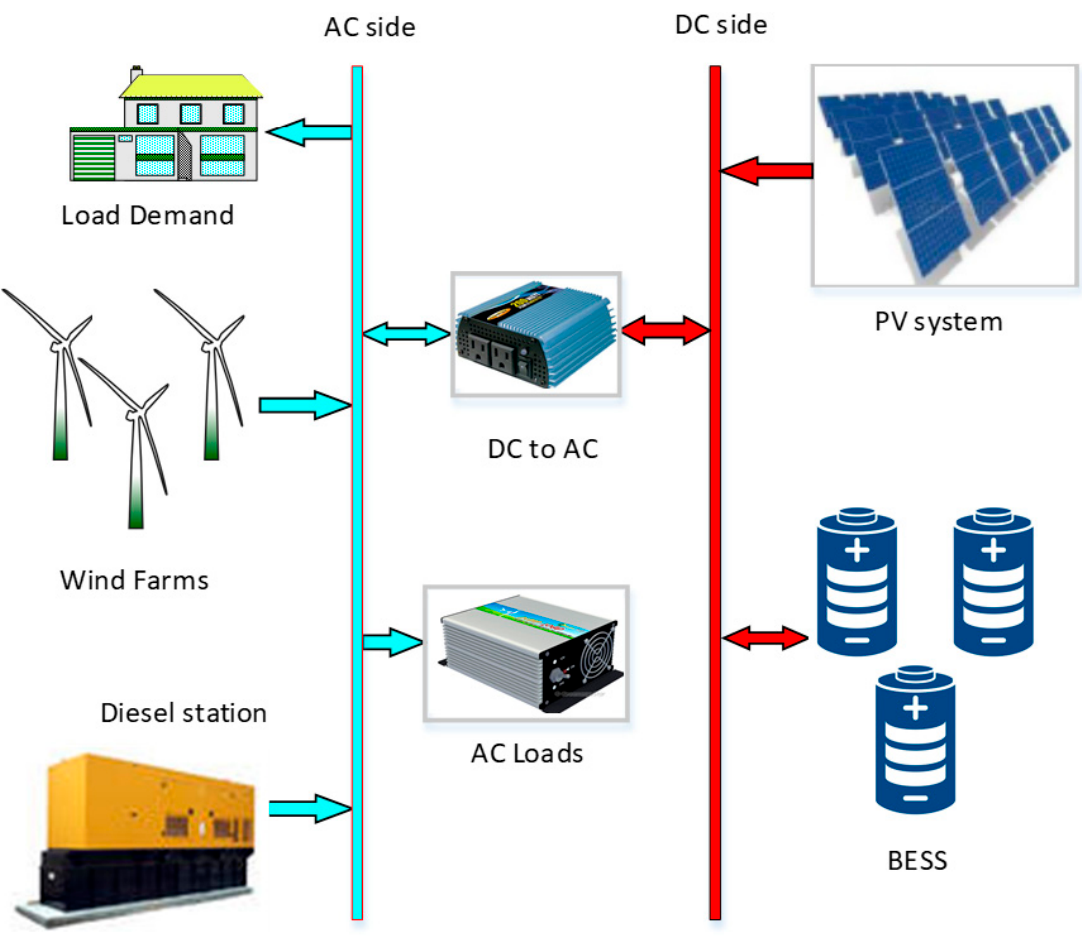
Figure 1. Schematic diagram of a microgrid system.